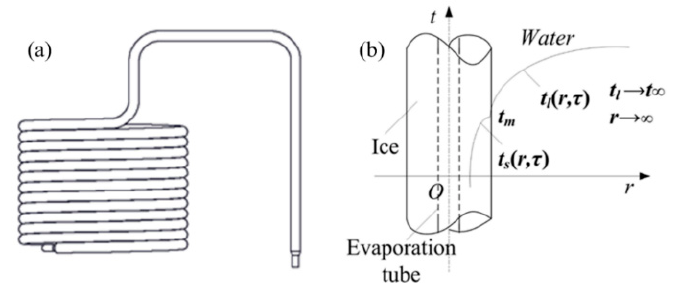
Figure 2. Evaporation coil and its simplified model of heat transfer with phase change: ( a ) 2D model of the evaporation coil; and ( b ) unsteady heat transfer in the ice storage process.